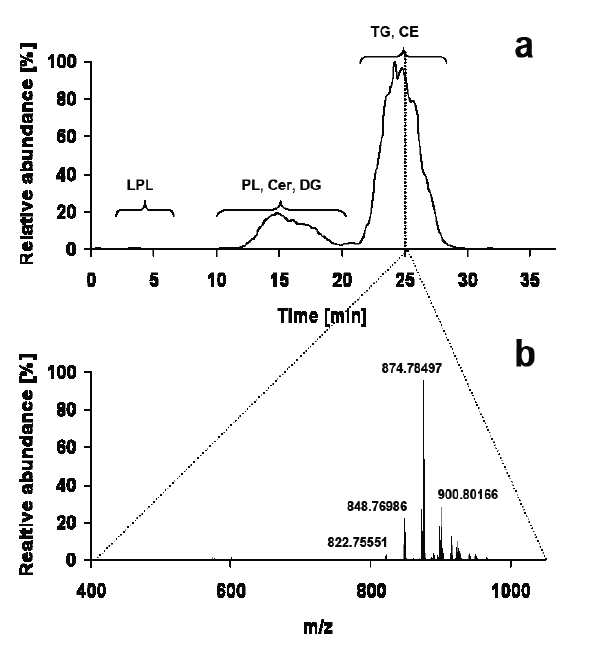
Figure 2. ( a ) Total ion chromatogram of a lipid droplet extract acquired on C-18 reversed phase HPLC coupled to an LTQ-FT in positive ESI mode ( b ) consisting of 487 individual full scan mass spectra at a resolution of 200,000. The expected m/z ranges for TG and CE are m/z 800–1,000 and m/z 600–700 respectively. Solvent A is water and solvent B acetonitrile / 2-propanol 5:2 (v/v). Both solvents contain 10 mM ammonium acetate and 0.1% HCOOH. The binary gradient starts at 50% B, increases to 70% B in 4 min and then to 100% B in another 21 min, where solvent B is held for 9